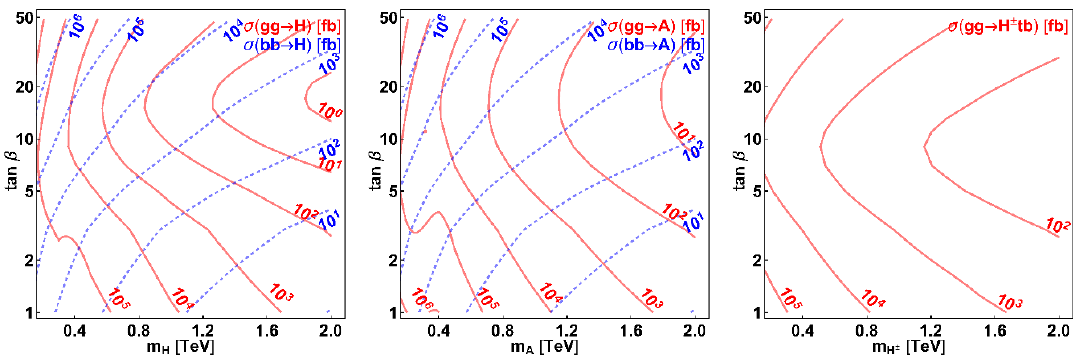
Figure 2 . Production cross sections for the heavy Higgs bosons H (left), A (center) and H (cid:6) (right) in a Type-II 2HDM in the alignment limit at a 100 TeV pp collider. The red and blue contours correspond to a gluon initial state and a bottom-quark initial state respectively.